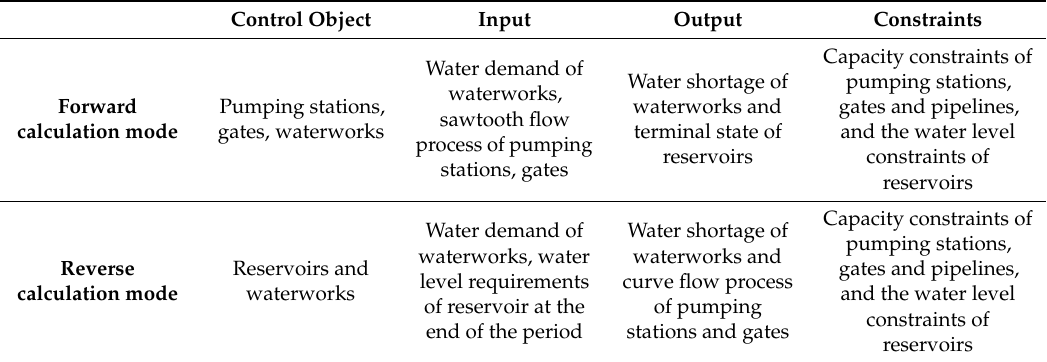
Table 2. Comparison of the forward calculation mode and reverse calculation